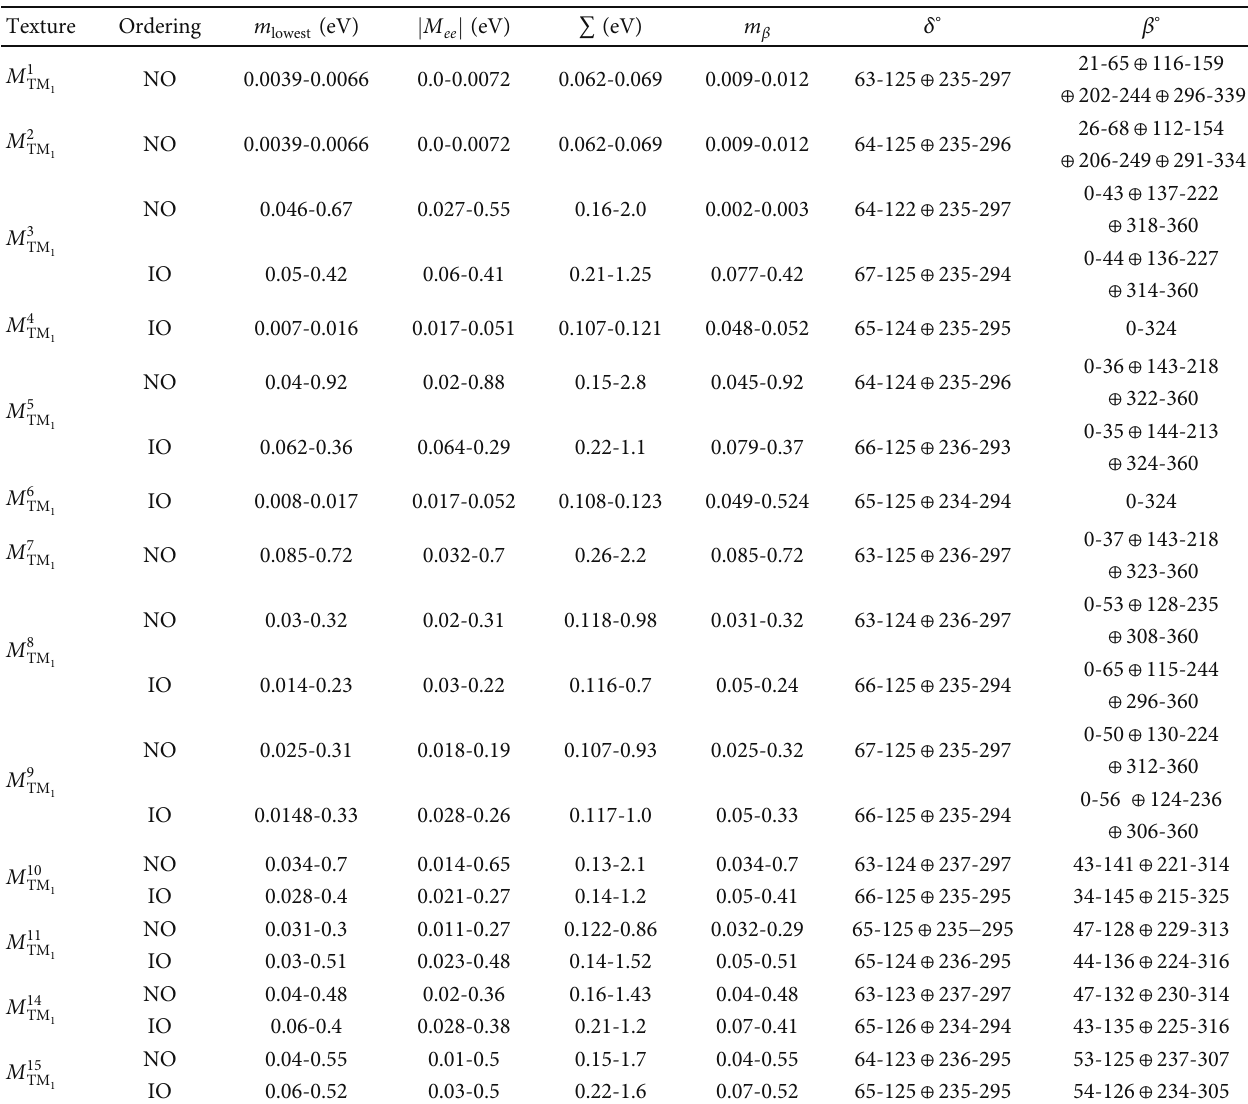
Table 5: Numerical predictions for viable textures having one equality in M